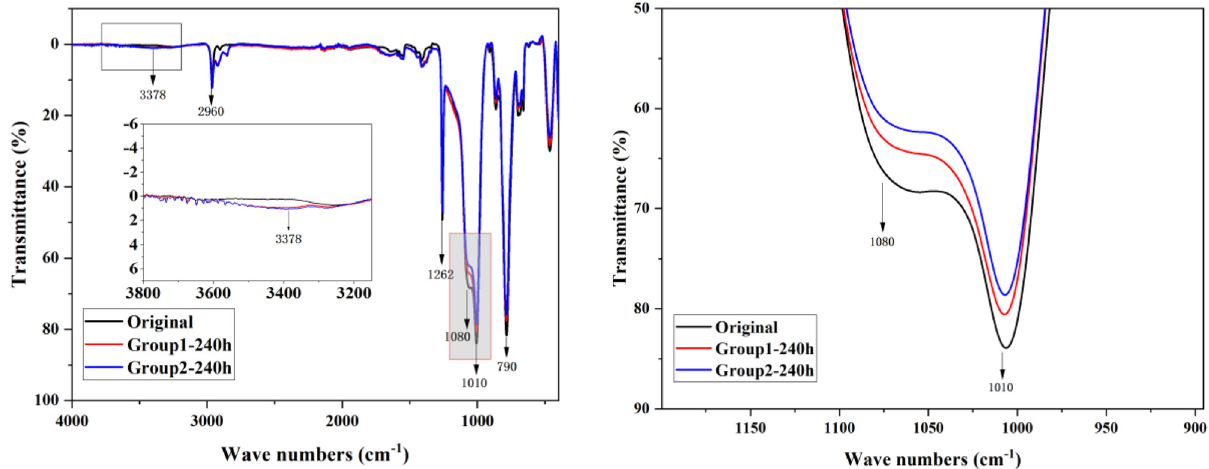
Figure 7: ATR - FTIR spectra of the LSR